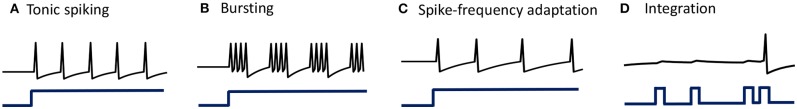
(A–D) Simulations demonstrating different single-neuron responses obtained using the GT neuron model.